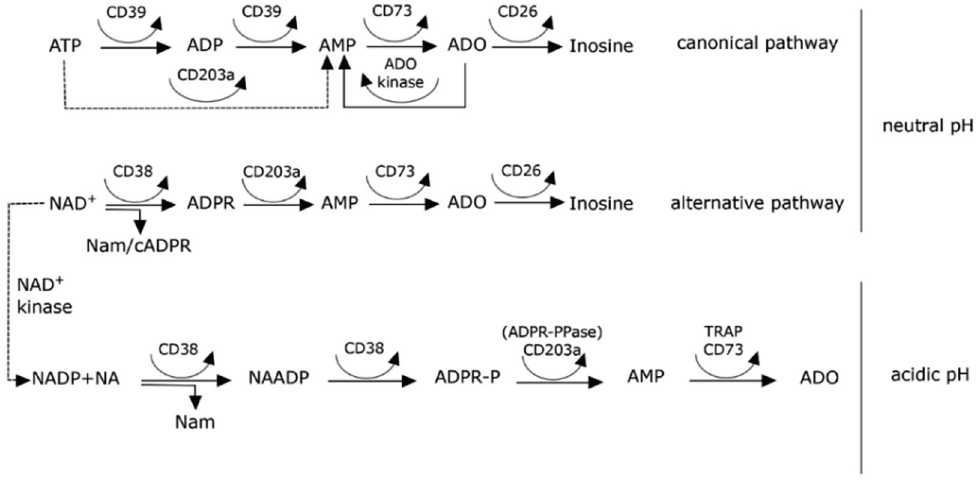
Figure 5. ADO production according to the environmental pH. Glossary: ADPR-P = ADP- ribose 2 ′ -phosphate, ADPR-PPase = ADP-ribose pyrophosphatase, TRAP = tartrate- resistant acid